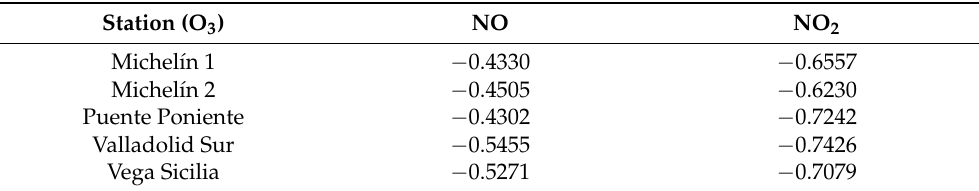
Table 5. Pearson correlation coefficients between monthly ozone concentrations and NO and NO 2 for each measuring station at a 95% confidence